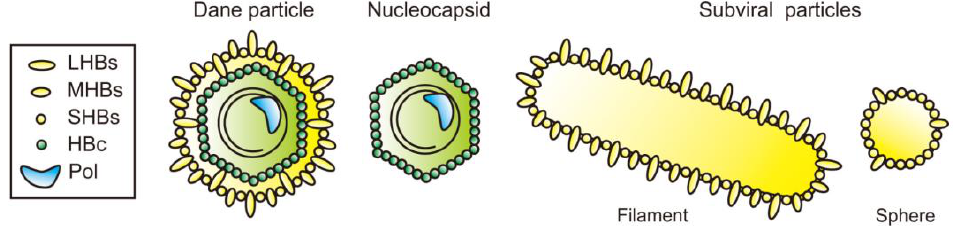
Figure 1. Schema of HBV-associated particles. Dane particles are 42 nm in diameter, and their envelope consists of large/middle/small hepatitis B surface proteins (LHBs/MHBs/SHBs) and a nucleocapsid containing viral genome and polymerase. There are 2 forms of subviral particles, filament and sphere. The former consists of LHBs, MHBs and SHBs, and the latter consists of MHBs and SHBs.